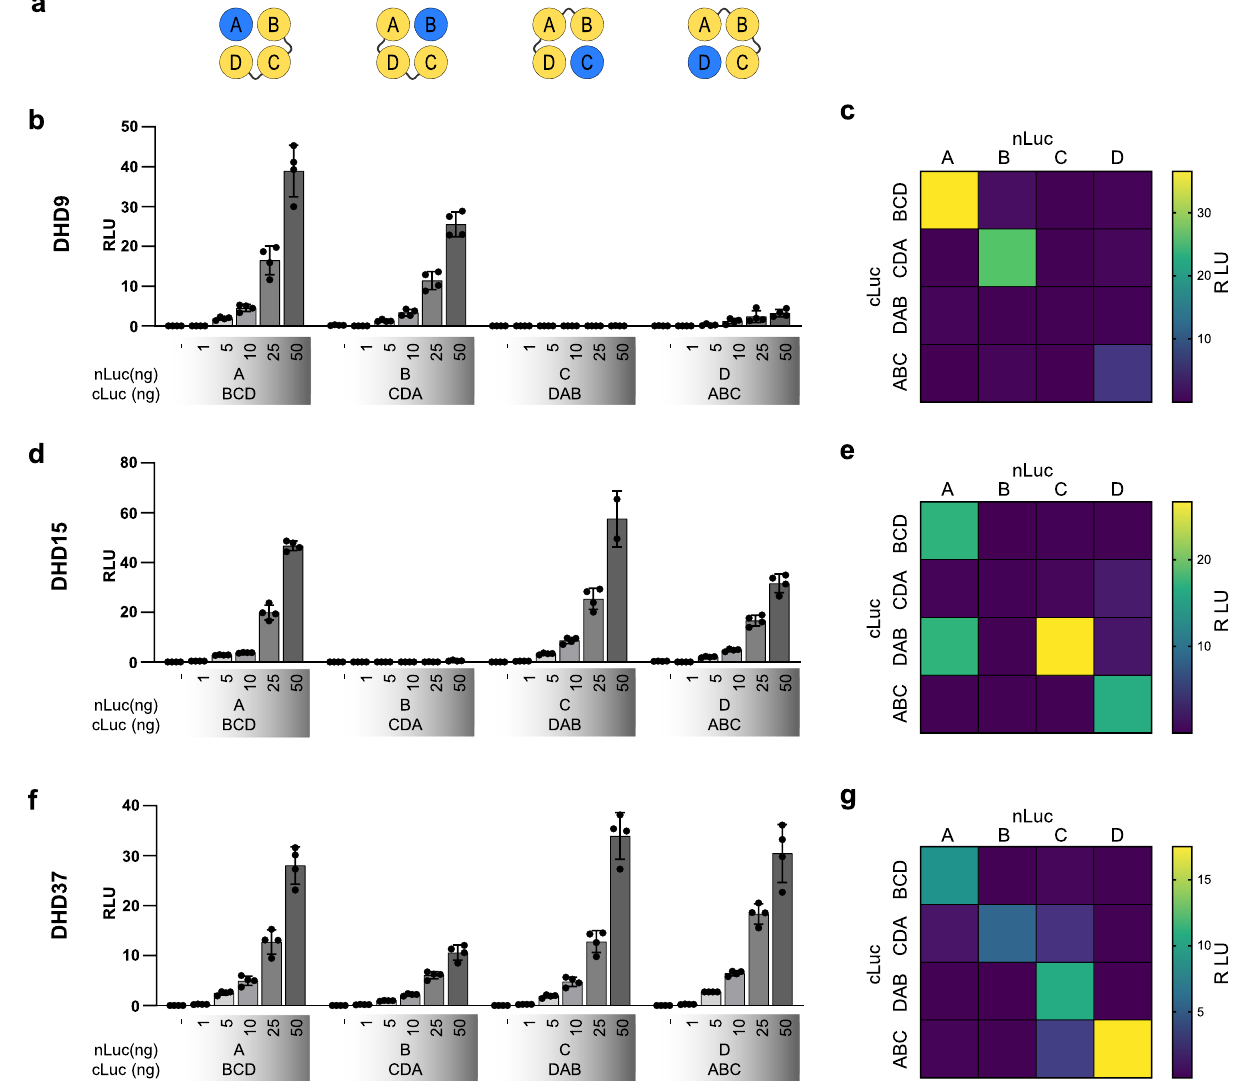
Fig. 5 | Four-helical bundle splitting strategy is applicable to diverse 4HBs and provides insight into the contribution of each segment to helical bundle for- mation. a Schematic representation of the generated 1:3 dimerization modules. b , d , f Titration of DHD9 ( b ), DHD15 ( d ), DHD37 ( f ) 4HB 1:3 dimerization domains. c , e , g Orthogonality of designed DHD9 ( c ), DHD15 ( e ), DHD37 ( g ) 4HB 1:3